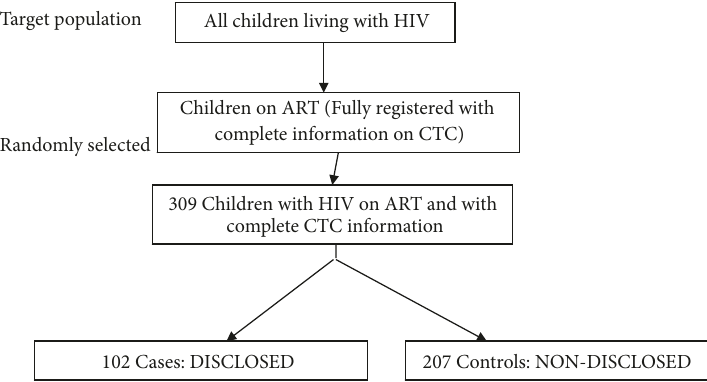
Figure 1: Showing sampling flow